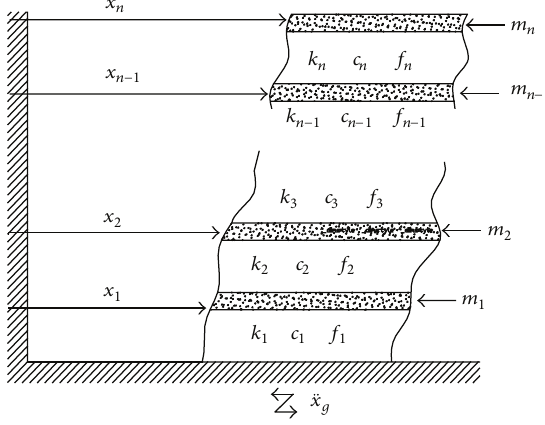
Figure 2: Lumped mass model of a multistory building with 𝑛 floors under acceleration ground input: 𝑥 1 ,𝑥 2 , . . . , and 𝑥 𝑛 indicate floors’ displacements; 𝑘 1 , 𝑘 2 ,... , and 𝑘 𝑛 indicate floors’ stiffness coefficients; 𝑐 1 ,𝑐 2 , . . . , and 𝑐 𝑛 indicate floors’ damping coefficients; ,𝑓 , . . . , and 𝑓 𝑓 1 2 𝑛 indicate distributed control forces; 𝑚 𝑛 indicate floors’ lumped masses; ground